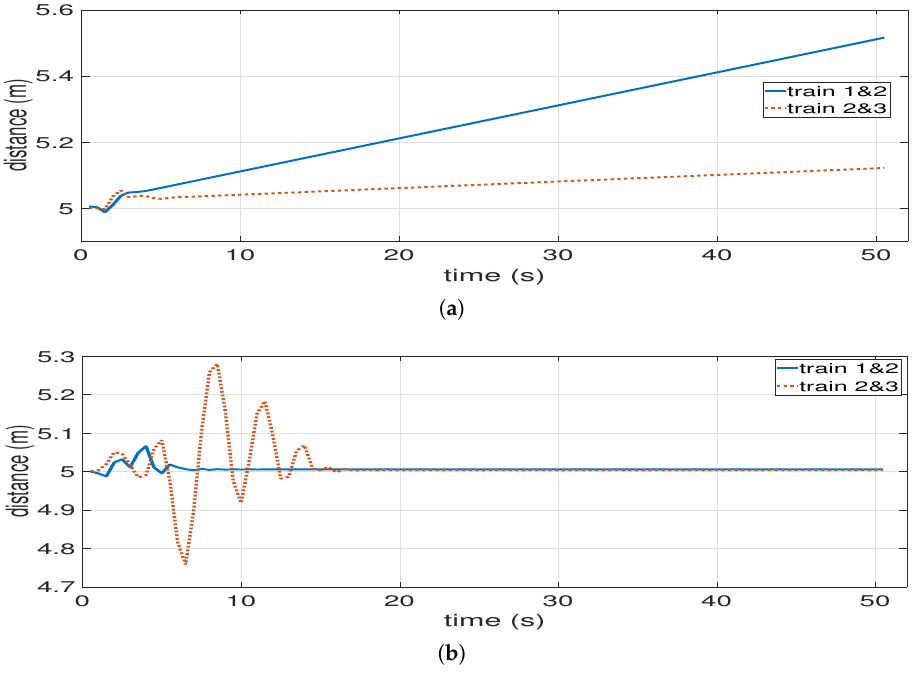
Figure 8. Comparison of speed profile. ( a ): The speed profile of trains with MPC system. ( b ): The speed profile of trains with AMPCVS system.